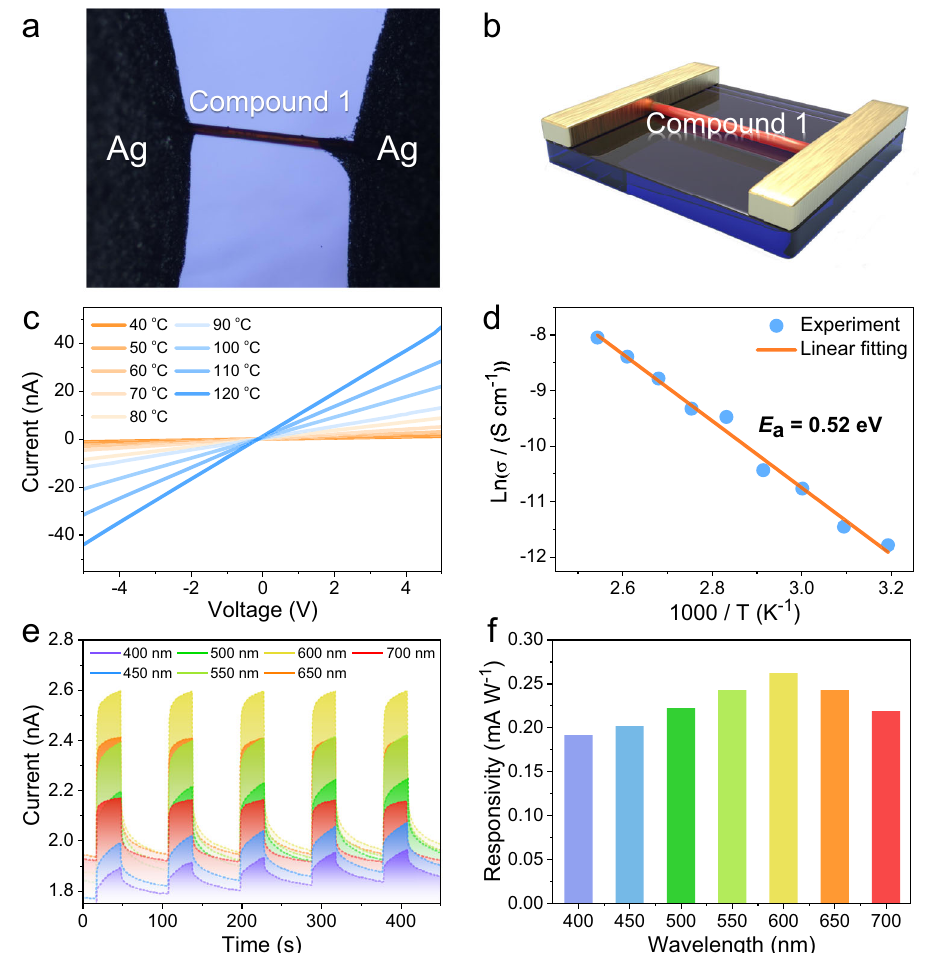
Fig. 3 Electrical conductivity and photoconductivity studies of 1. a Optical photographic image, and ( b ) a schematic diagram of the single crystal of 1 used for electrical measurements. c Temperature-dependent I – V curves, and ( d ) corresponding Arrhenius plots for 1. e Time-dependent photocurrent response curves, and ( f ) responsivities of 1 under illumination at different light wavelengths. Source data for panels ( c ) – ( e ) are provided as a Source Data fi